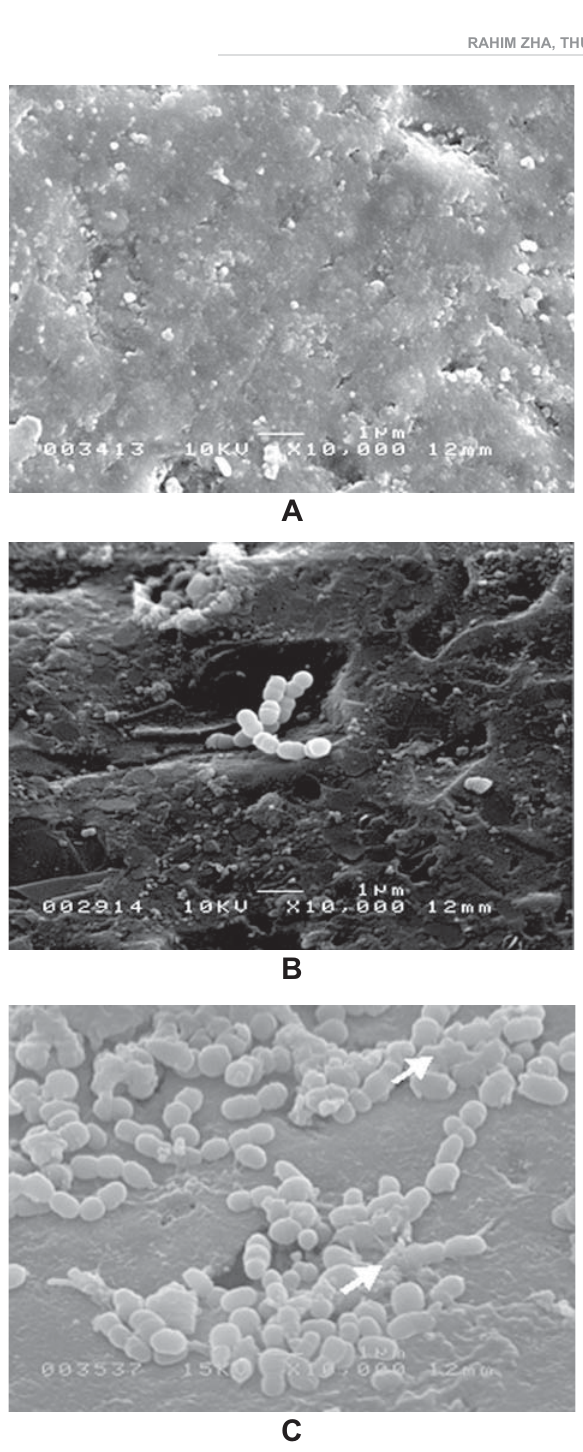
Figure 2- Scanning electron microscope micrographs of S. mutans cells grown on glass beads in the absence and presence of 1% sucrose. A: Blank control (10,000x). Note the absence of bacteria on the glass bead’s surface. B: S. mutans cells grown in the absence of sucrose (10,000x). There were not many cells adhering to the glass surface and they appeared to be in the dividing state. C: S. mutans grown in the presence of sucrose (1%) (10,000x). There were many cells adhering to the glass surface. The cells appeared to be covered by thick sticky extracellular